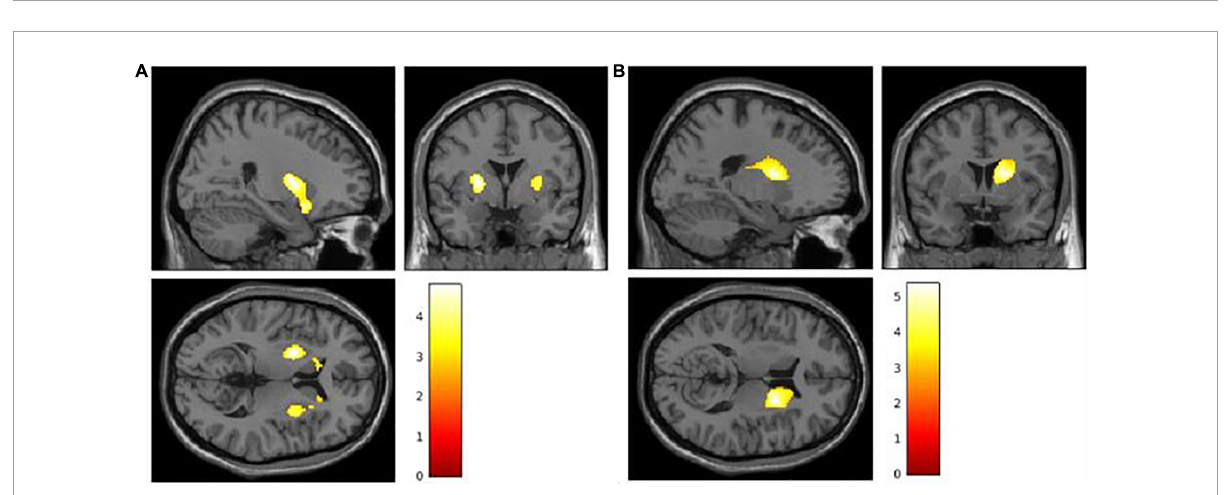
FIGURE2 (A) Correlation between gray matter volume and principal ideas score. (B) Correlation between gray matter volume and entire recall Z-score. Colored voxels show regions for which statistical analysis is significant at p < 0.005 at the voxel level and FDR-corrected at p < 0.05 at the cluster